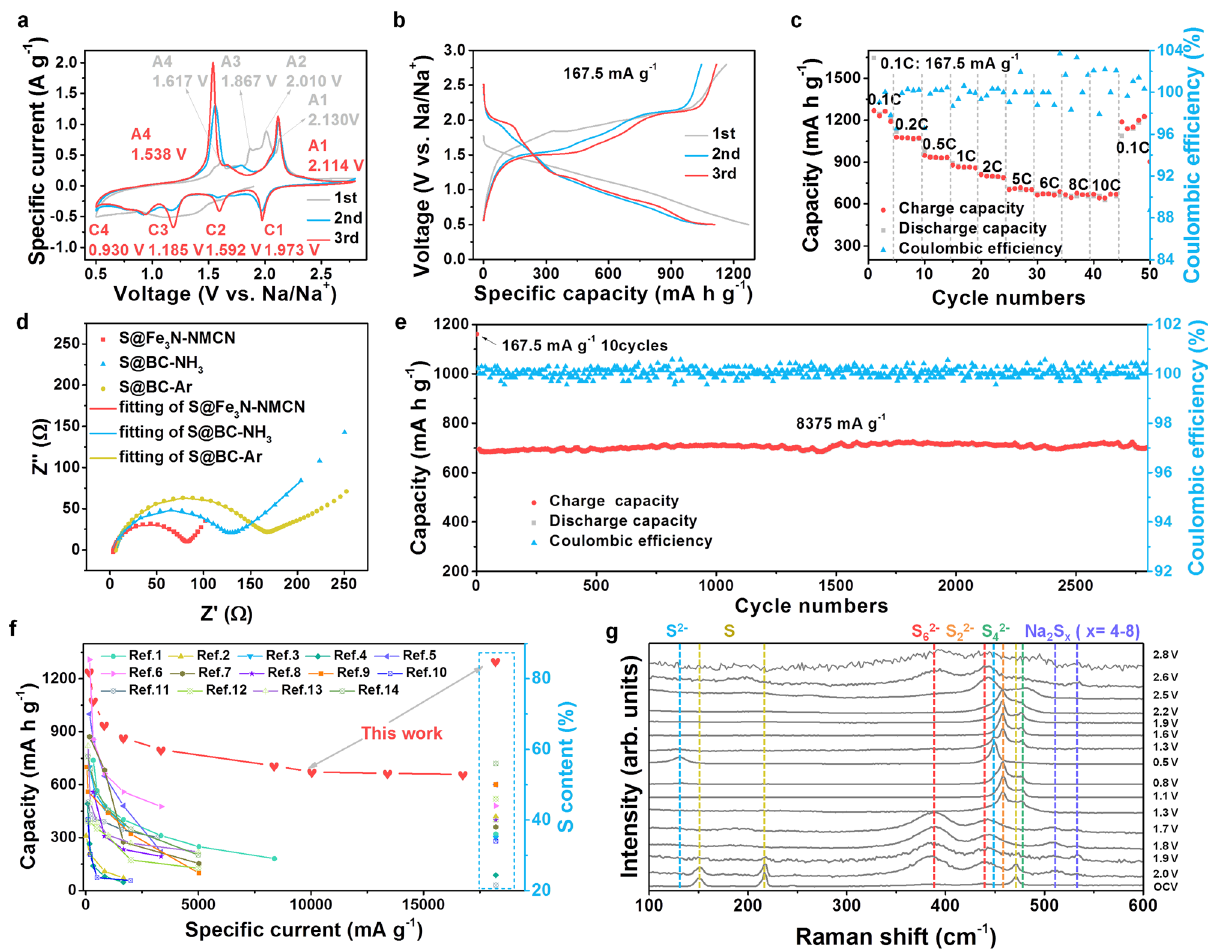
Fig. 5 Electrochemical energy storage performances of the Na – S@Fe 3 N-NMCN cell. a First three CV curves at a scan rate of 0.2 mV s − 1 . b First three voltage-capacity curves at a speci fi c current of 167.5 mA g − 1 . c Rate capability at speci fi c currents of 167.5, 335, 837.5, 1675, 3350, 8375, 10050, 13400, 16750 mA g − 1 . d Comparison of EIS spectra between BC-Ar, BC-NH 3 , and Fe 3 N-NMCN before the rate test. e Long-term cycling performance at a speci fi c current of 8375 mA g − 1 . f Comparison of electrochemical performance and sulfur content with previous literature. g In situ Raman spectra at a speci fi c current of 167.5 mA g − 1